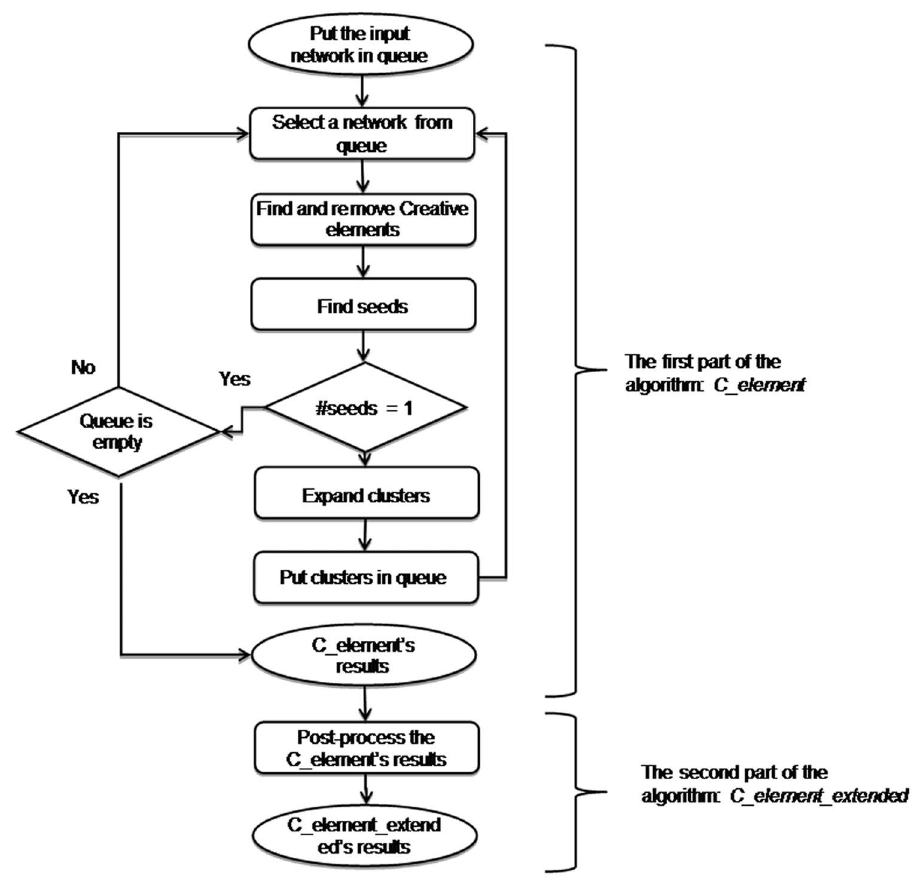
Figure 1. An overview of the proposed algorithm; the algorithm consists of two main parts.